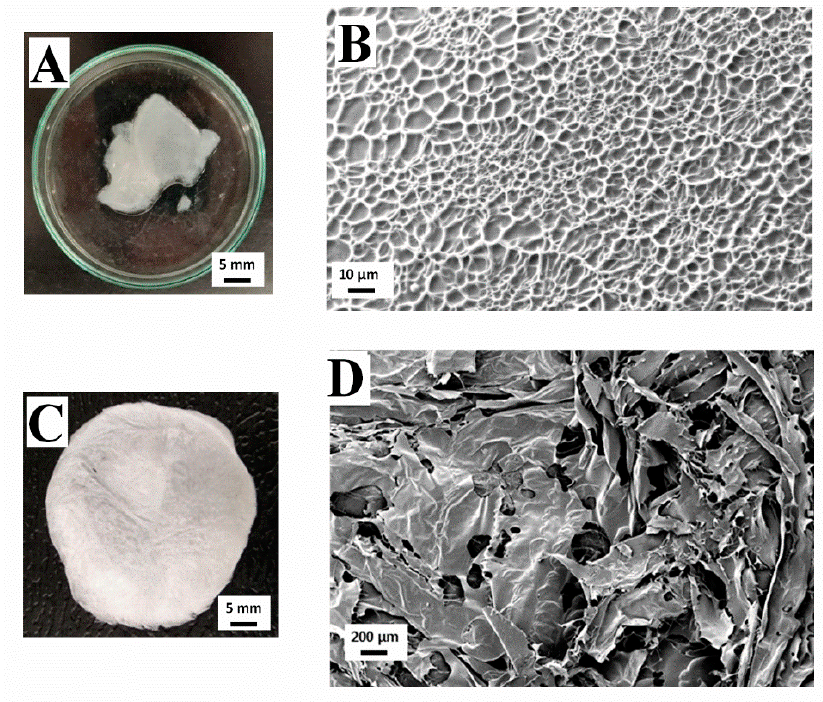
Figure 2. Macroscopic and microscopic images of a collagen-based hydrogel ( A , B ) and a collagen- based aerogel ( C , D ) at a concentration of 10 mg/mL.